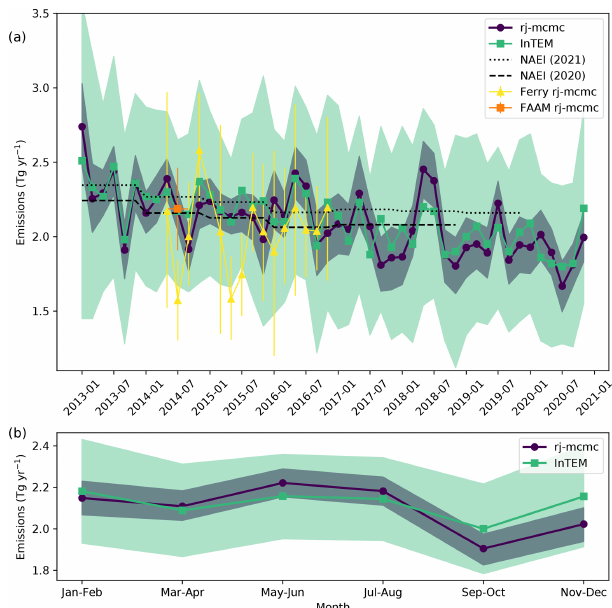
Figure 3. (a) Time series of 2-monthly UK emissions from the two inversion methods, showing the rj-mcmc spatially varying inversion (purple) and InTEM inversion (green). The rj-mcmc results are also included from the mobile measurement platforms of the ferry (yel- low) and the FAAM aircraft (orange). The solid lines and mark- ers designate the means, while the shading and uncertainty bars show the 95% confidence intervals of the posterior distributions. Black dashes show the NAEI annual mean from the two most re- cent reports (NAEI2020 and NAEI2021). (b) The mean seasonal cycle of 2-month mean emissions from the full network inversions between 2013 and